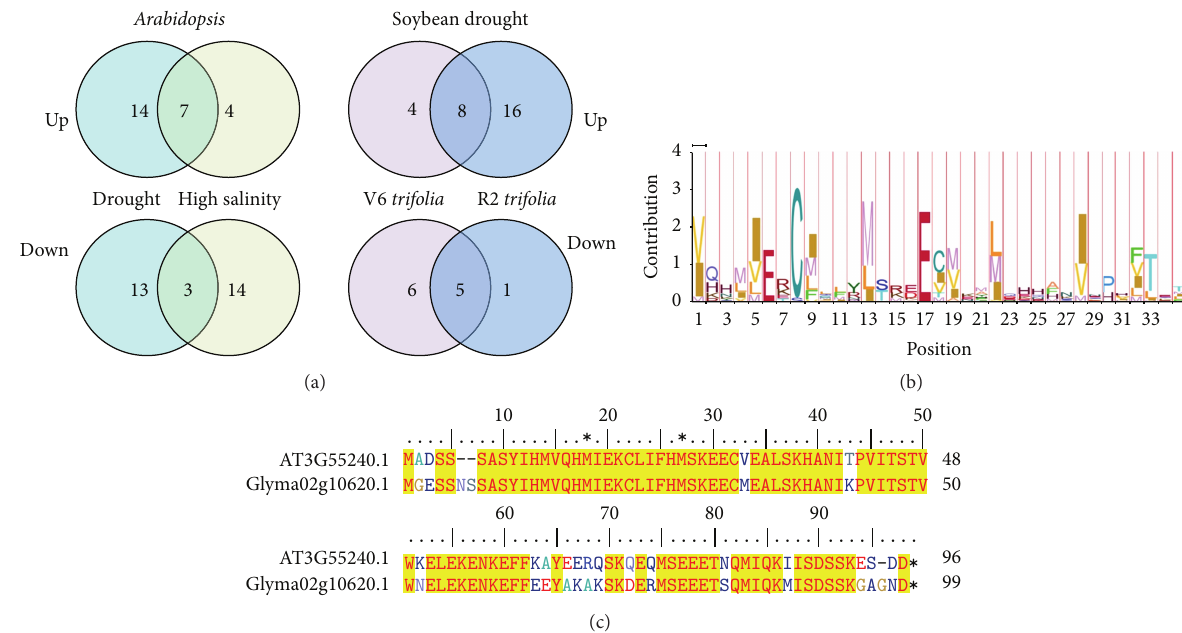
Figure 2: Venn diagram analyses of the expression of MRP-coding genes in Arabidopsis and soybean under abiotic stresses (a), and HMM profile of Arabidopsis and soybean homologs share common responsiveness to drought (b) and their peptide sequence alignment (c).